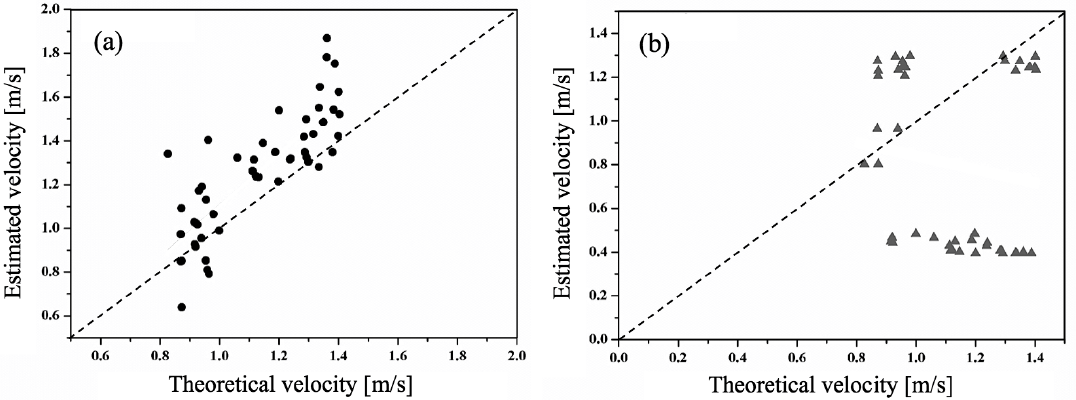
Figure 11. Estimated and theoretical IW phase velocities of selected points in Figure 8. ( a ) Velocities estimated using the difference between the ENVISAT and MODIS images with a time difference of 55 minutes. ( b ) Velocities estimated using the IW packets with a time difference 12.42 hours [64].